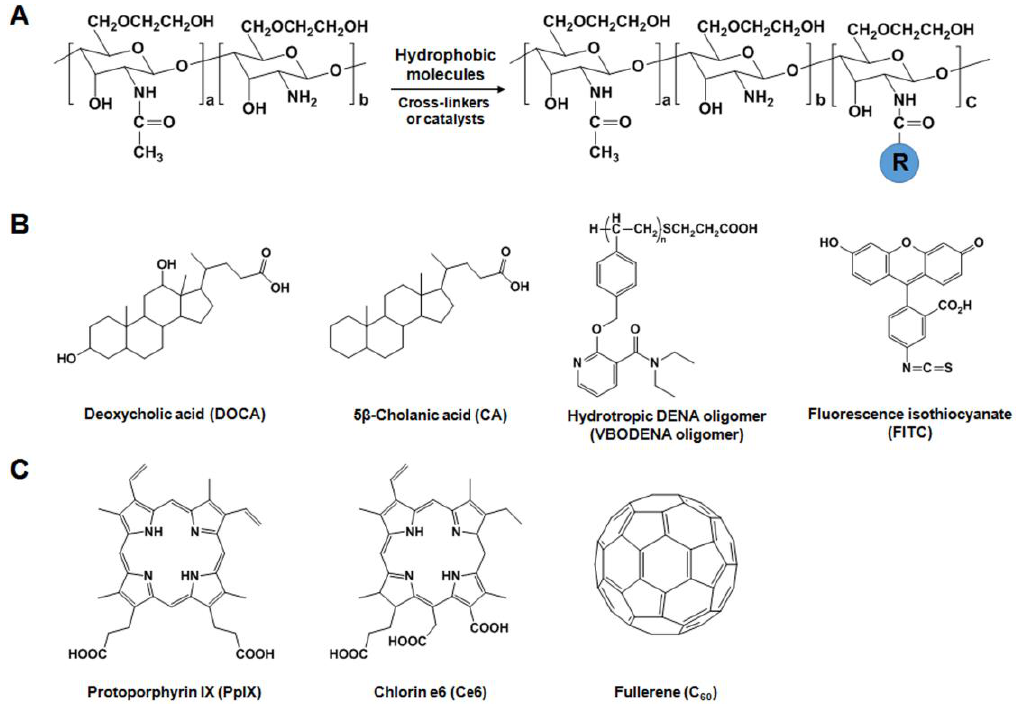
Figure 1. ( A ) General preparation methods of hydrophobically modified glycol chitosan (HGC) derivatives. HGC derivatives were chemically modified with various hydrophobic molecules in the presence of crosslinkers or catalysts. R means hydrophobic moieties. ( B ) Examples of hydrophobic molecules for preparation of HGC-based drug carriers. ( C ) Several photosensitizers such as PpIX, Ce6 or C 60 can be coupled to GC for photodynamic therapy.